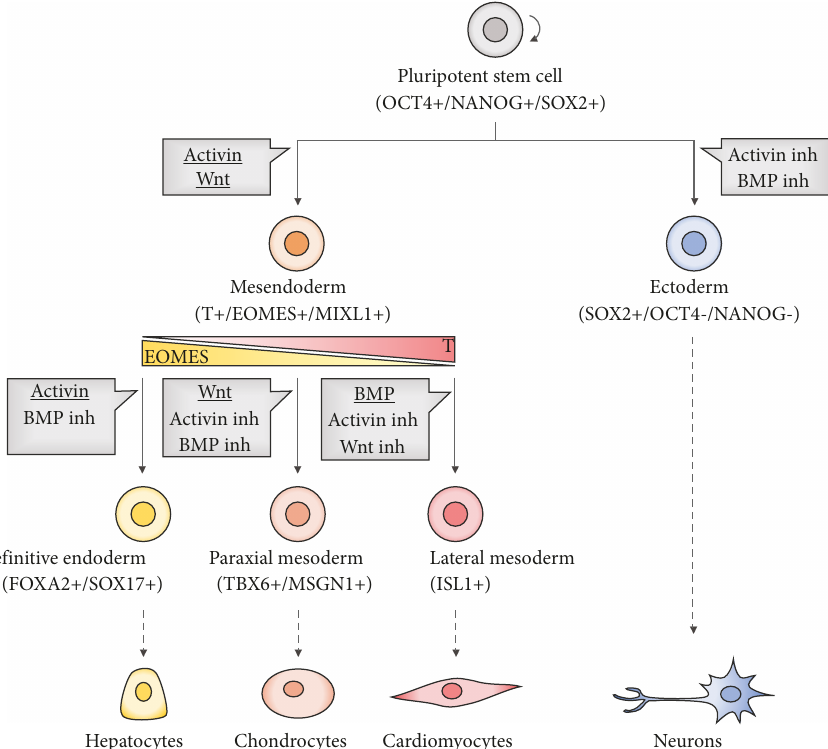
Figure 4: Lineage speci fi cation from PSCs. Ectoderm induction is achieved by dual SMAD inhibition, whereas mesendodermal di ff erentiation is based on the activation of dual SMAD regulators and WNT signaling. Dashed arrows represent examples of di ff erent cell types achieved by manipulating speci fi c lineage di ff